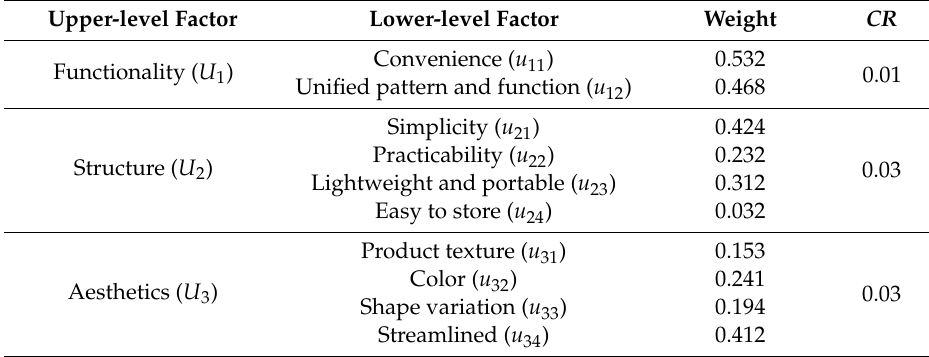
Table 4. Weight set of lower-level factors of evaluation indices for pillbox design for patients with chronic